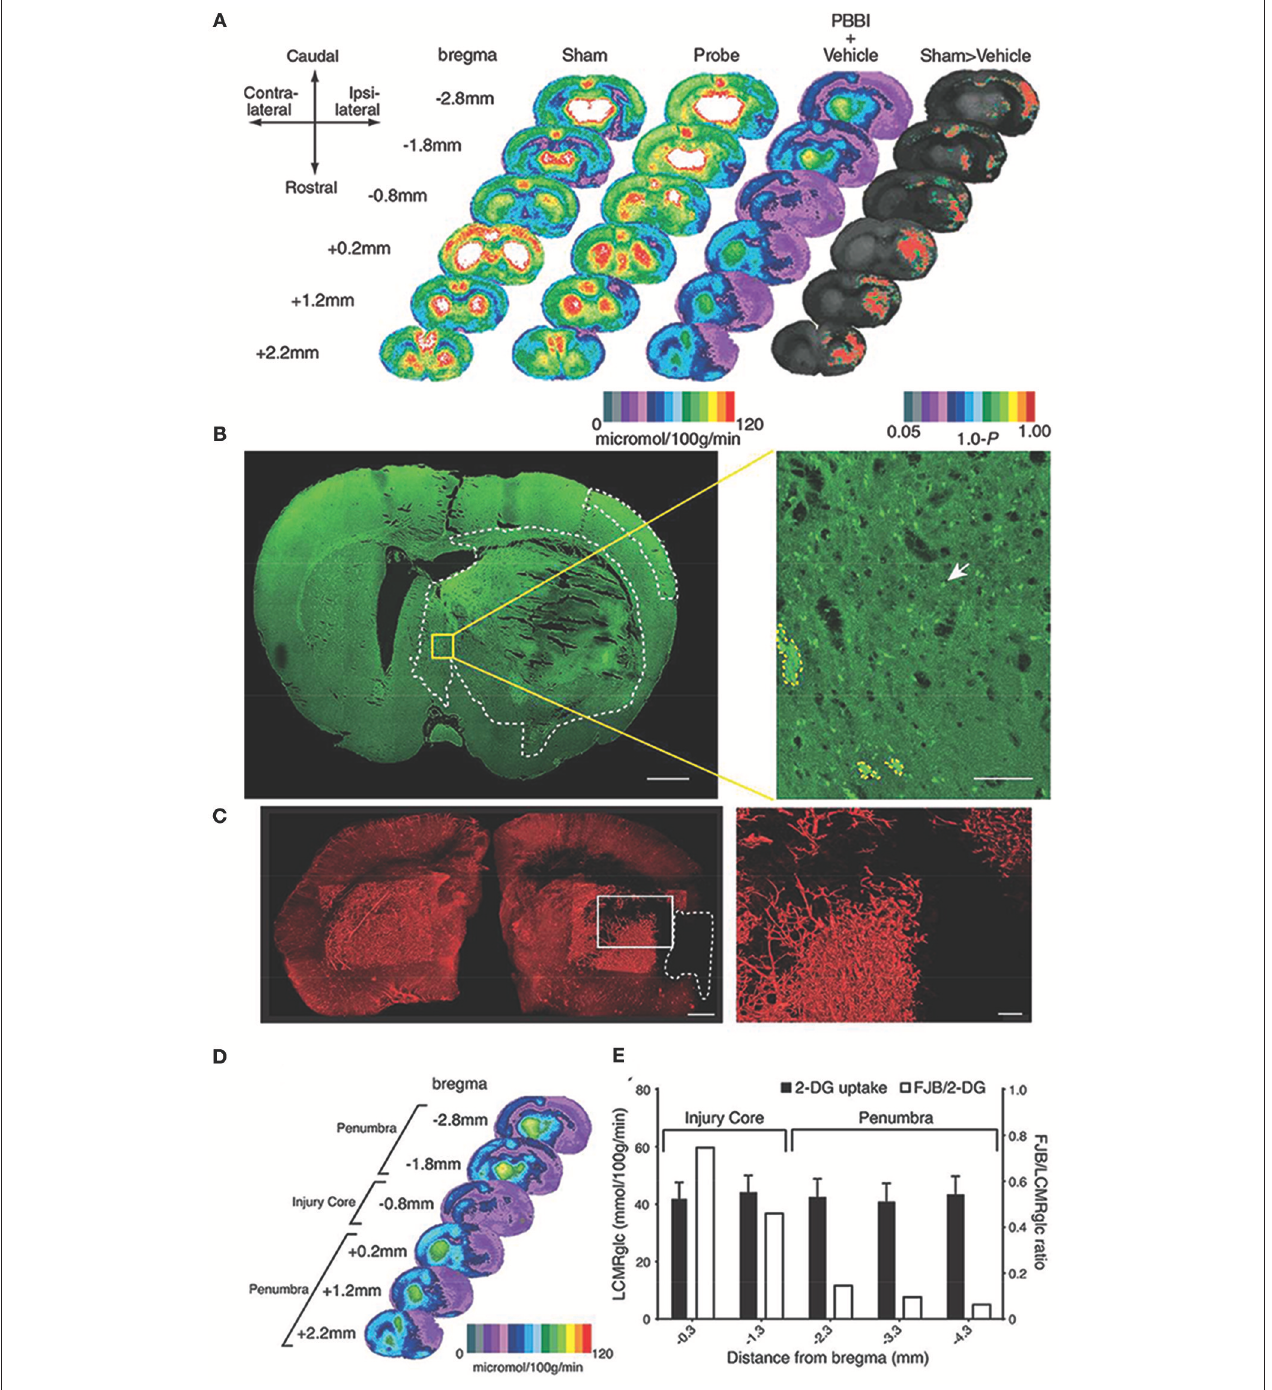
FIGURE 1 | Local cerebral glucose metabolism after penetrating ballistic-like brain injury (PBBI) (A) is shown as color-coded maps of average local cerebral metabolic rate for glucose (LCMRglc) at 2.5h after injury. Each coronal section is a representation of multiple animals within a group at that particular level. Rat brain atlas levels are given on the left column as millimeters from bregma. Compared with controls (columns 1 and 2) in PBBI (column 3), LCMRglc decreased radially from injury core into perilesional areas and globally across the entire brain. P-maps of average local cerebral glucose utilization were produced by comparing the values of pixels corresponding to the same anatomic position across groups. (B) Confocal image of a Fluorojade B (FJB)-stained coronal section at 0.8mm distance from bregma shows regions with FJB + cells (circumscribed by white-dotted line). Greater neurodegeneration was observed in the injury core and peri-injury zone in the ipsilateral than those in the contralateral cerebral cortex. (C) Composite light sheet microscopy image shows ipsi and contralateral hemispheres perfused with fluorescent